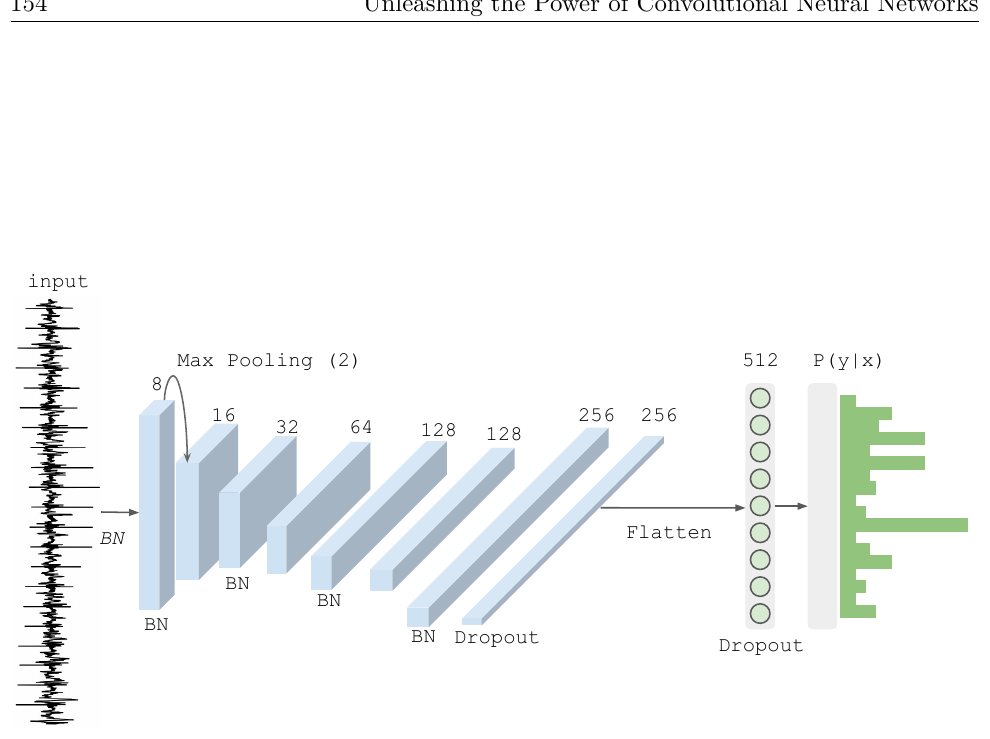
Figure 1: An example schema of the CNN architecture. This particular configuration is used for the AES HD dataset. The model encodes a trace into latent representation such that the final layer can output the posterior probability for each label. The blue tensors indicate the activation after the convolution layer conv φ m , . The number on ReLU top of each block indicates the number of channels used for the corresponding convolution layer. ‘BN’ indicates that the batch normalization is applied to the corresponding layer, and ‘Dropout’ is used in a similar manner referring to the dropout layer. The gray box with green circles refers to the fully-connected layer fc θ n , . Finally, the rightmost ReLU component in the pipeline is the output of the final fully-connected layer fc θ, that softmax outputs the probability for each 256 label. As it can be seen, a convolutional neural network is a sequence of layers, and every layer of a network transforms one volume of activation functions to another through a differentiable function. Input holds the raw features. Convolution layer computes the output of neurons that are connected to local regions in the input, each computing a dot product between their weights and a small region they are connected to in the input volume. ReLU layer will apply an element-wise activation function, such as the max (0 , x ) thresholding at zero. Max Pooling performs a down-sampling operation along the spatial dimensions. The fully-connected layer computes either the hidden activations or the class scores. Batch normalization is used to normalize the input layer by adjusting and scaling the activations after applying standard scaling using running mean and standard deviation. To convert the output of a convolution part of CNN (which is 2-dimensional) into a 1-dimensional feature vector that is used in the fully-connected layer, we use the flatten operation. Dropout is a regularization technique for reducing overfitting by preventing complex co-adaptations on training data. The term refers to dropping out units (both hidden and visible) in a neural